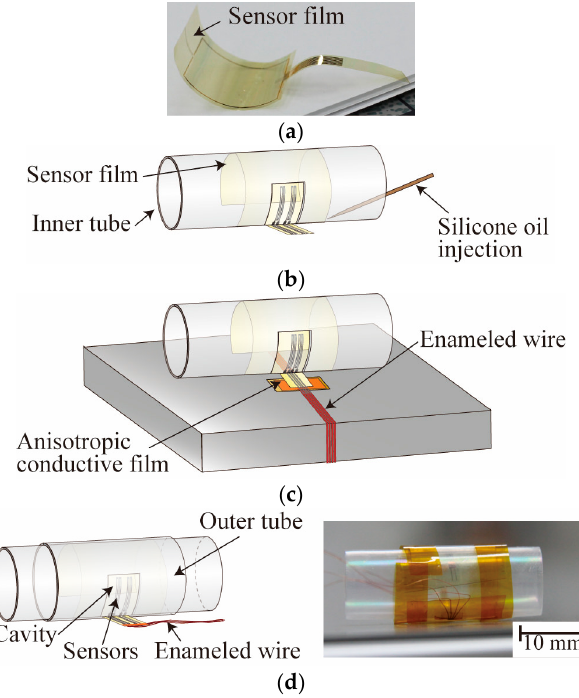
Figure 3. Assembly of sensor film into tube: ( a ) Plastically bent sensor film; ( b ) Applying silicone oil into gap between film and tube; ( c ) Wiring connection and parylene C deposition; ( d ) Inserting sensor into outside